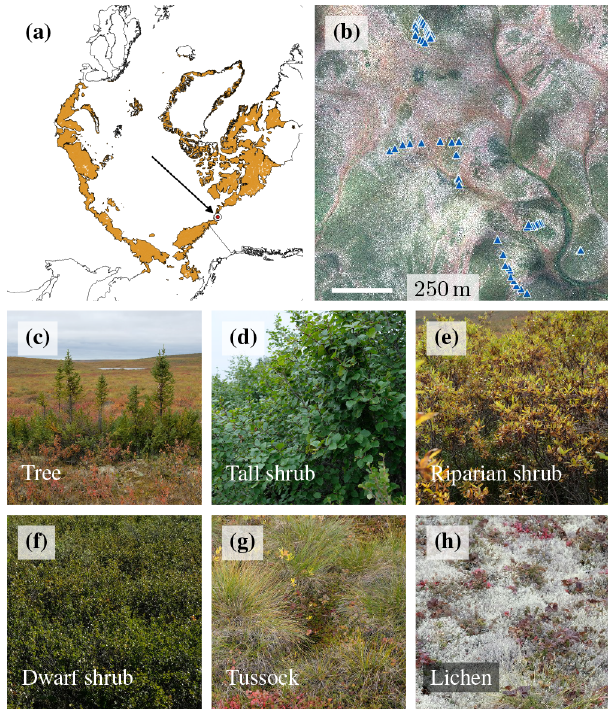
Figure 1. (a) Location of the Trail Valley Creek research station, Northwest Territories, Canada and Arctic tundra extent in orange colour (data from Walker et al., 2005), (b) airborne orthophoto (Po- lar 5 aeroplane, MACS camera, August 2018) of the site includ- ing topsoil temperature measurement locations, (c–h) six vegetation types used in this